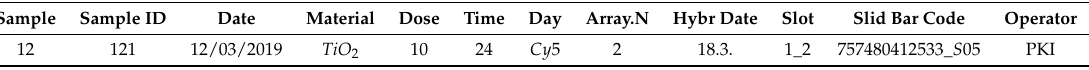
Table 1. Example of the phenodata table